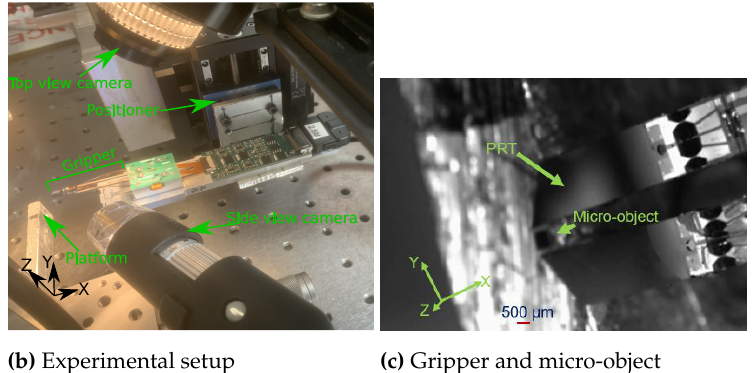
Figure 15. Instrumented microgripper and experimental